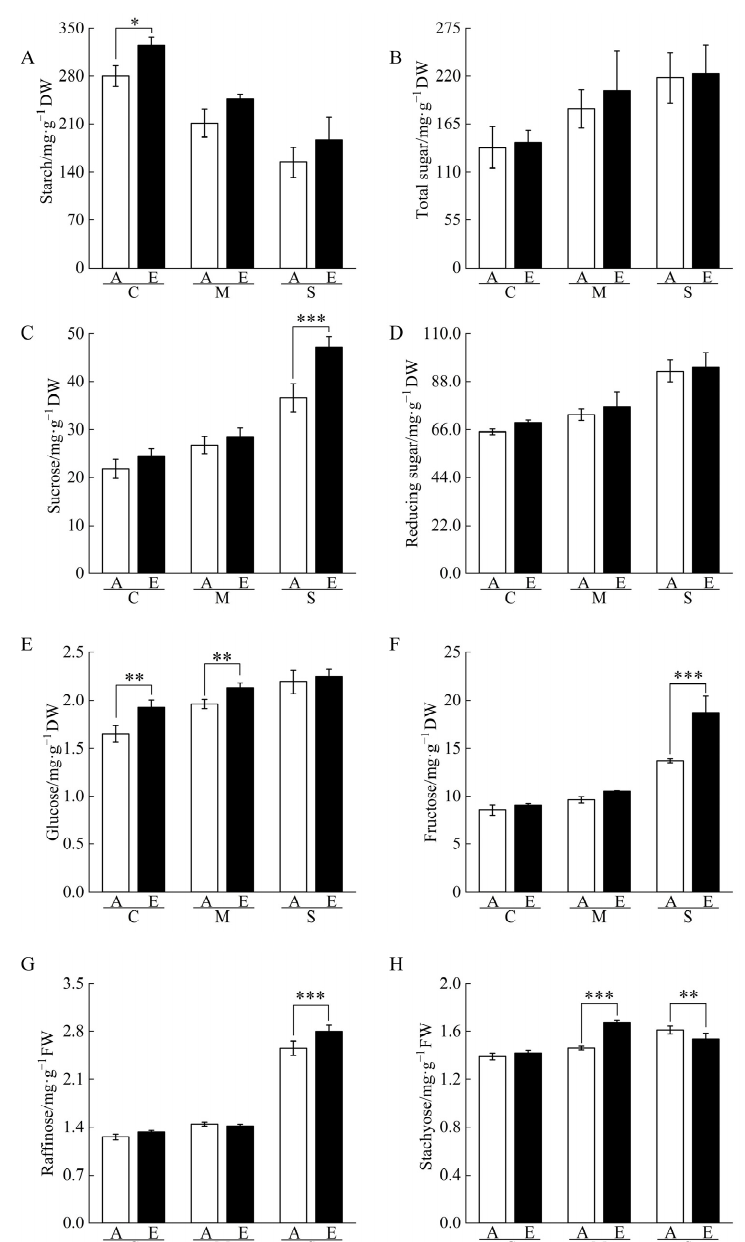
Figure 5. Effects of [CO 2 ] enrichment on the contents of non-structural carbohydrates in roots of cucumber seedlings under drought stress. ( A ) Starch, ( B ) Total sugar, ( C ) Sucrose, ( D ) Reducing sugar, ( E ) Glucose, ( F ) Fructose, ( G ) Raffinose, ( H ) Stachyose. All results are expressed as the mean ± standard deviation (SD) of three repeated values; *, difference is significant at the 0.05 level; **, difference is significant at the 0.01 level; ***, difference is significant at the 0.001